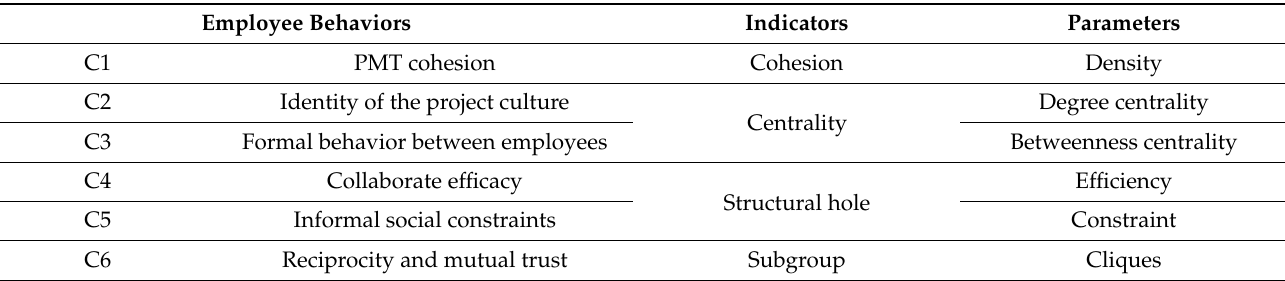
Table 2. Parameters of SNA include employee